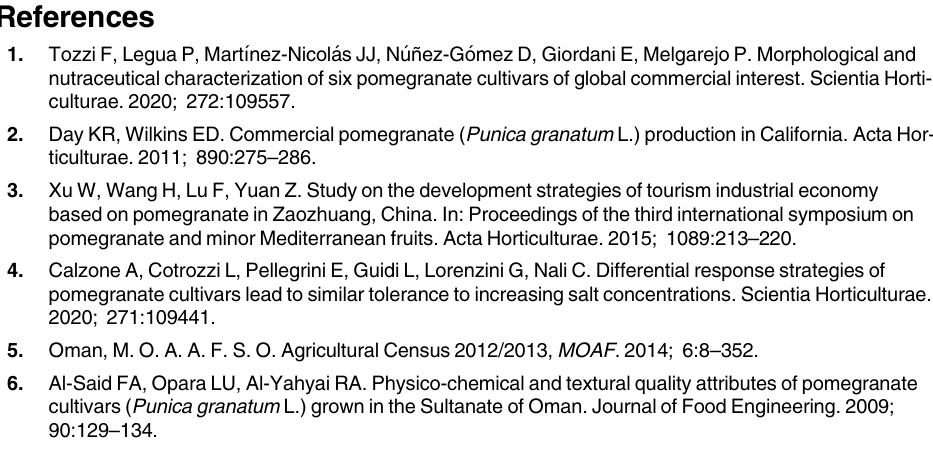
S1 Table. Taxa, GenBank accession numbers, species group placement, collection location, and references associated with the sequence data used in the phylogenetic analyses. Species group/complex placement mainly follows Johnson (1984) and Taekul et al.